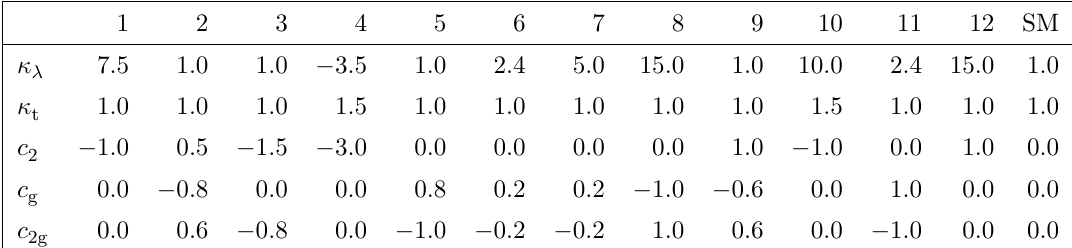
Table 1 . Coupling parameter values in the SM and in twelve BSM benchmark hypotheses identified using the method described in ref.